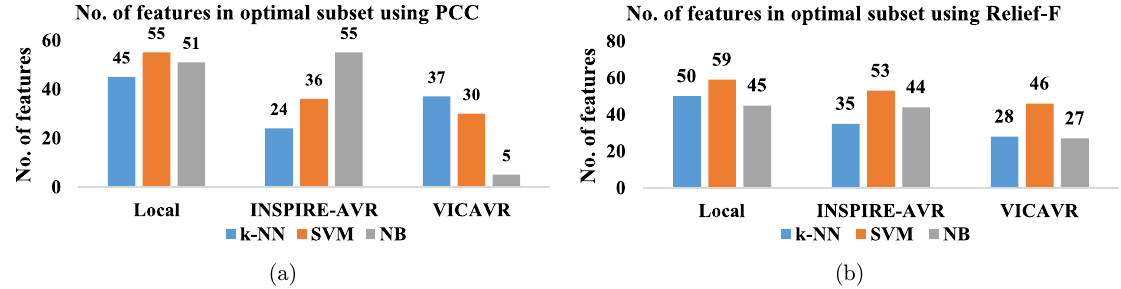
Fig. 16. Number of features in optimal feature subsets acquired from two ranking schemes with classi¯cation accuracy of three classi¯ers. (a) Number of features in optimal feature subsets using PCC method and (b) Number of features in optimal feature subsets using Relief-F method.